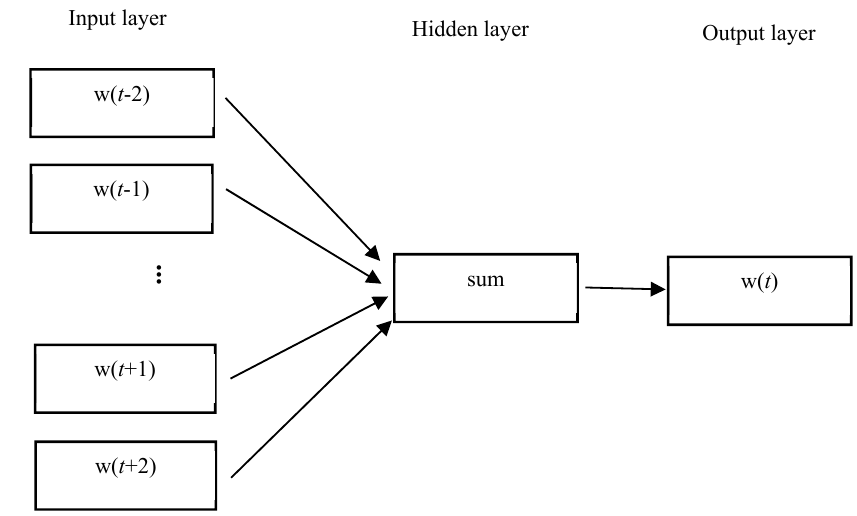
Figure 1. Training the word vectors using the CBOW model.